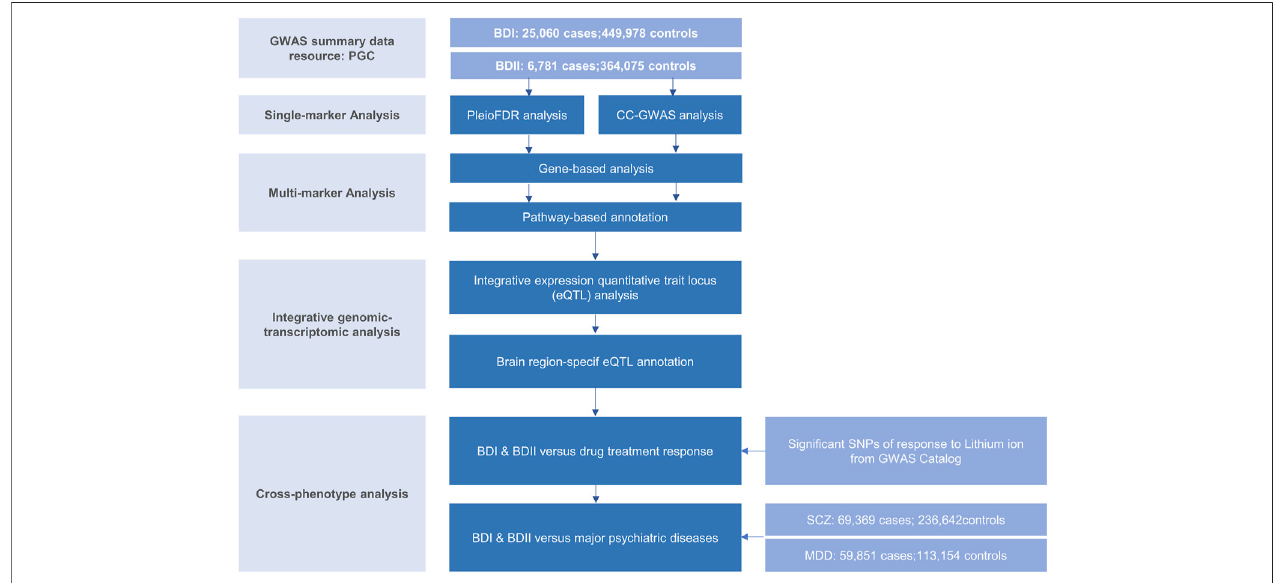
FIGURE1| Work fl owofkeymethodologicalsteps inthisstudy. PGC: psychiatric genomicsconsortium, BD I:bipolar disorder typeI, BDII: bipolar disorder type II, SCZ: schizophrenia, MDD: major depressive disorder.